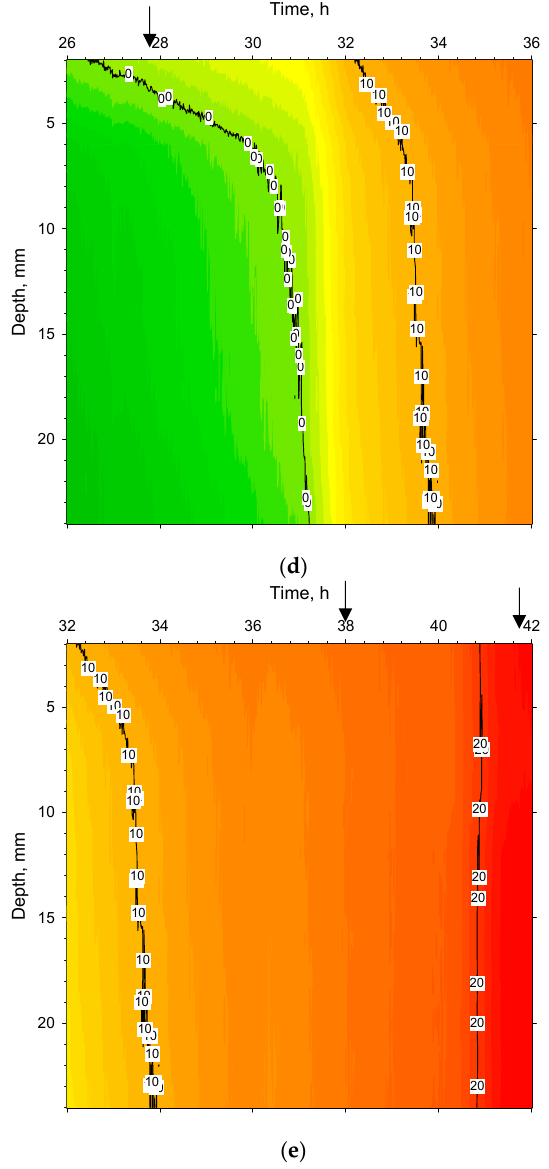
Figure 7. ( a ). Time/temperature profile from 1.6 to 2.8 h at ambient pressure based 72 thermograms of Ge-cuvette along depth profile shown in Figure 4b (freezing). Arrow at 2.05 h shows time-point of spatial contour plot for cuvette-side (shown in Figure 8a). Super-cooled liquid zone visible just before 2 h. ( b ). Time/temperature profile from 3 to 14 h based on 660 thermograms of Ge-cuvette along depth profile shown in Figure 4b, (freezing, annealing, and start of sublimation). Arrows at 4 h, 7 h, and 12.2 h show time points of spatial contour plot of the cuvette-side shown in Figure 8b–d, respectively. Ambient pressure from 3 h to 11 h and 0.05 mbar from 11–14 h. ( c ).Time/temperature profile from 18 to 28 h based on 600 thermograms of Ge-cuvette along depth profile shown in Figure 4b (sublimation). Arrows show positions at 19.2 h, 22.8 h and 27.8 h of spatial contour plot of the cuvette-side as shown Figure 8e–g, respectively. Pressure was 0.05 mbar from 18 to 28 h. ( d ).Time/temperature profile from 26 to 36 h based on 600 thermograms of Ge-cuvette along depth profile shown in Figure 4b (sublimation). Arrow shows position of spatial contour plot of the cuvette-side at 27.8 h (Figure 8g). Pressure was 0.05 mbar from 26 to 36 h. ( e ). Time/temperature profile based on 600 thermograms of Ge-cuvette along depth profile shown in Figure 4b from 32 to 42 h, (secondary drying). Arrows show positions at 38 h and 41.7 h of spatial contour plot of the cuvette side as shown in Figure 8h,i, respectively. Pressure was 0.05 mbar from 32 to 36 h and 3 µ bar from 36 to 42